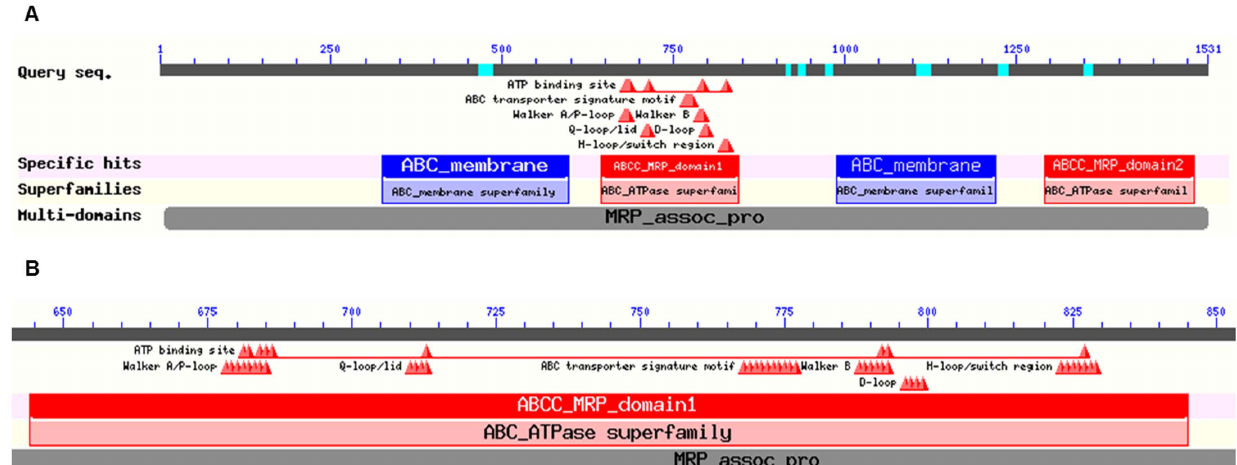
Figure 1. Schematic representation of functional domains of ABCC1. Figure depicts functional domains of ABCC1 protein (A) and important structural motifs within NBD1 (B). Data modified from NCBI’s Conserved Domain Database (CDD) [49].